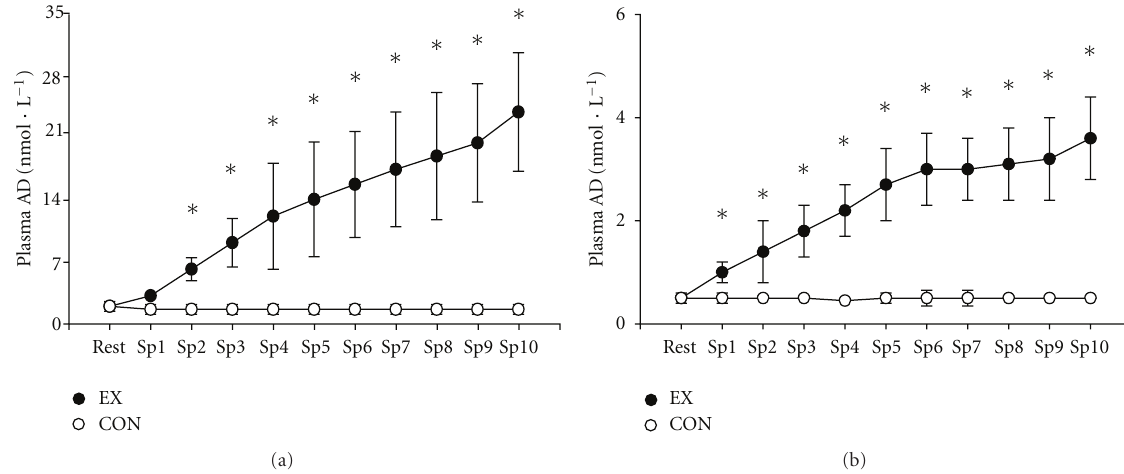
Figure 1: Plasma noradrenaline (NA) and adrenaline (AD) concentration of subjects at rest (CON) and following each 6-second sprint (EX) (mean ± SD, n = 12). ∗ Indicates a significant di ff erence from equivalent CON value ( P < . 05). (Adapted from Bracken et al. [16]).